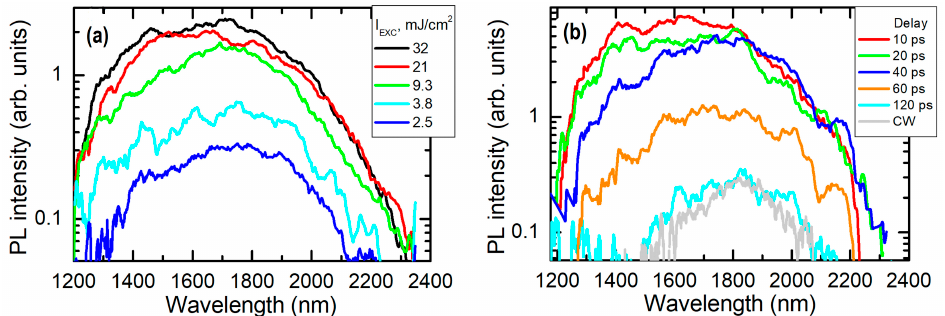
Figure 6. Excitation fluence ( a ) and temporal ( b ) dependencies of PL spectra at 32 mJ/cm 2 excitation. In ( b ), CW spectra obtained using an infrared spectrometer are shown for comparison.